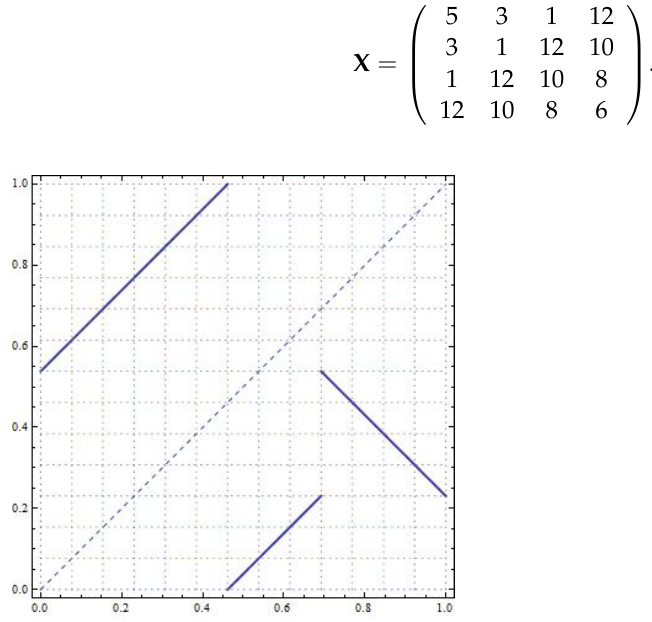
Figure 15. The graph of a ( 3,1 ) -IET with permutation ( 3,1, − 2 ) and λ = ( 6,3,4 )